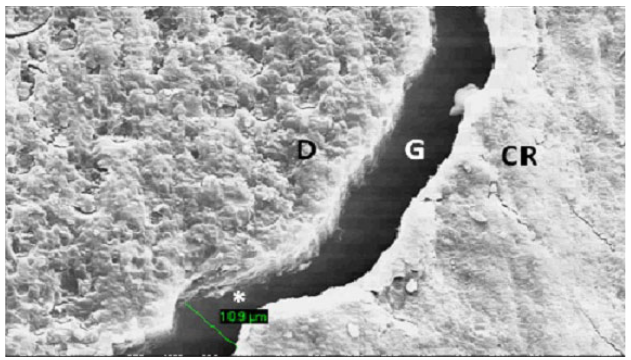
Fig. 1. Scanning electron micrograph of a representative marginal gap. A gap can be seen at the interface between dentin and the composite restoration (original magnification ×1000). The asterisk indicates the gap width being measured. D - dentin; G - gap; CR – composite